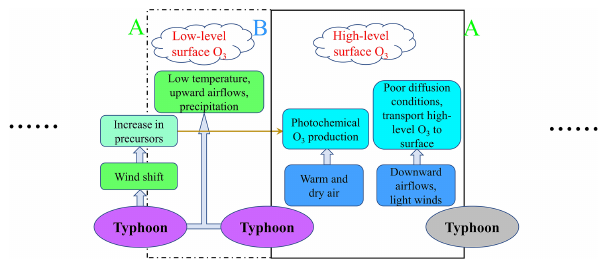
Figure 11. A schematic diagram of major processes showing that summertime O 3 is affected by landfall typhoons in the YRD. The letter A indicates the moment that the typhoon has reached the 24h warning line, and the letter B indicates the last moment when ty- phoon remains active in mainland